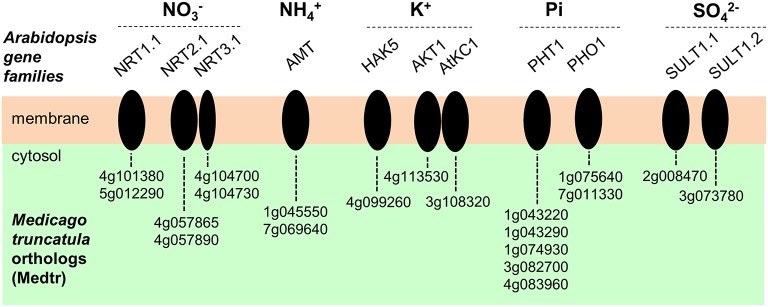
Plasma membrane transport systems likely to play a role in transport of macronutrient ions in Medicago truncatula root hairs. Candidate genes potentially involved in nitrate (NO3-), ammonium (NH4+), orthophosphate (Pi), potassium (K+) or sulfate (SO42-) transport are represented. The corresponding acronyms in Arabidopsis are provided. NRT, NitRate Transporter. AMT, AMmonium Transporter. HAK, High Affinity K+ transporter. AKT, Arabidopsis K+ transport system (from the Shaker channel family). AtKC1, Arabidopsis thaliana K+ channel 1 (member from the Shaker channel family). PHO1, PHOsphate 1. PHT1, PHosphate Transporter 1. SULT, SULfate Transporter.